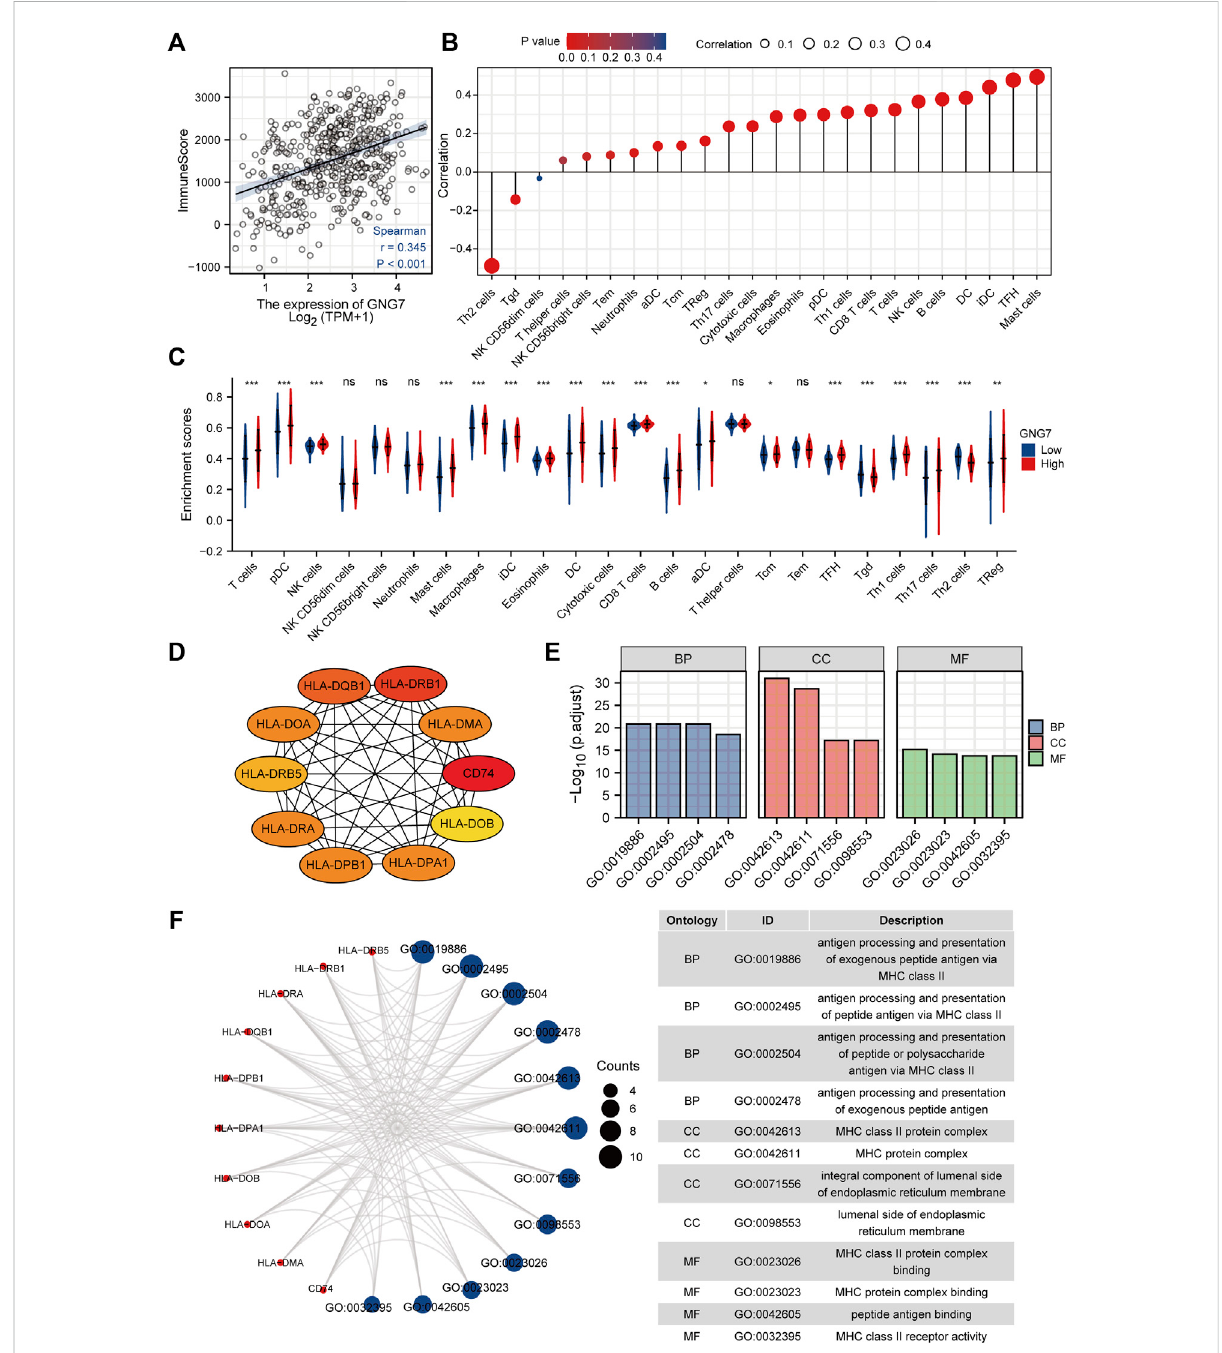
FIGURE 6 Correlation of immune cell in fi ltration and GNG7 expression in LUAD patients. (A) Relationship between immune scores and GNG7 expression levels in LUAD. (B) Relationships between in fi ltration levels of 24 immune cell types and GNG7 expression pro fi les by Spearman ’ s analysis. (C) Comparison of the immune in fi ltration level of 24 immune cell types between GNG7-high and GNG7-low groups. LUAD, lung adenocarcinoma; DCs, dendritic cells; aDCs, activated DCs; iDCs, immature DCs; pDCs, plasmacytoid DCs; Th, T helper cells; Th1, type 1 Th cells; Th2, type 2 Th cells; Th17, type 17 Th cells; Treg, regulatory T cells; Tgd, T gamma delta; Tcm, T central memory; Tem, T effector memory; Tfh, T follicular helper; NK, natural killer. (D) The top10 hub genes calculated with the MCC algorithm by cytoHubb. (E) The top 4 enriched GO terms of BP, CC and MF categories of the GO enrichment analysis. (F) The network including the hub genes and the enriched GO terms. BP, biological process; CC, cellular component; MF, molecular